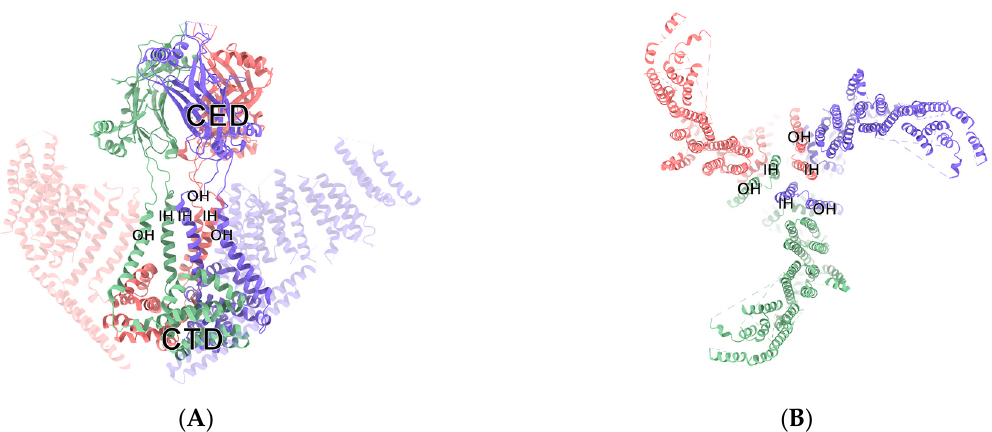
Figure 1. Structure of Piezo 1 channel protein (PDB: 3JAC). ( A ) The main view of Piezo1 protein. For a clear view of the channel, some domains outside the channel core are transparentized or hidden. ( B ) A view from the top of Piezo1 protein (central sliced). Domains which construct the channel core are labeled in A and B.